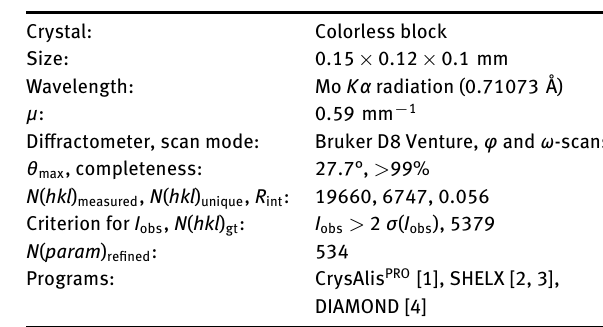
Table 1: Data collection and